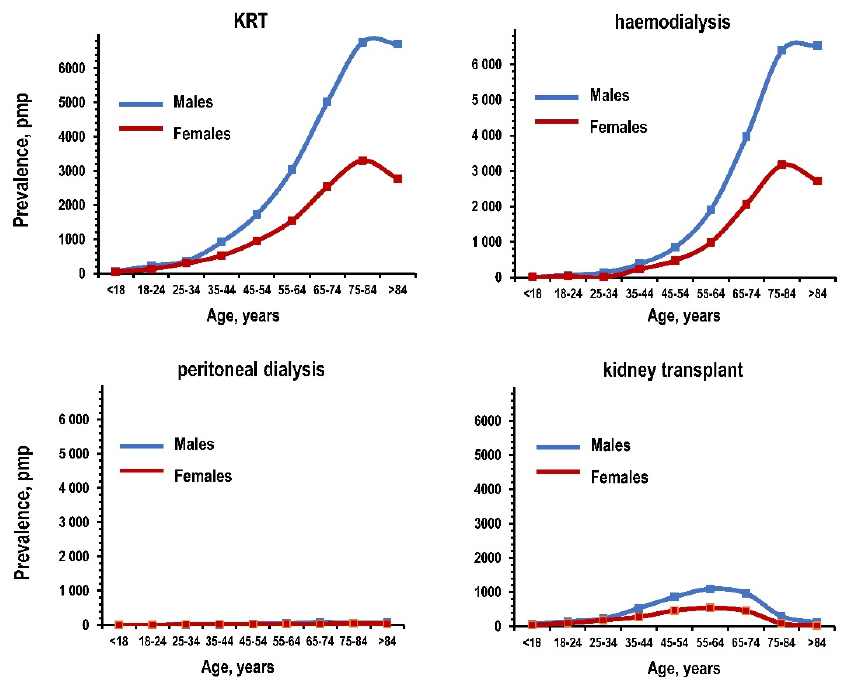
Figure 1. Prevalence of kidney replacement treatment, haemodialysis, peritoneal dialysis, and kidney transplant among residents of the Campania region in the year 2017: patients per million population (pmp) by age and gender. Notes: blue line for males and red line for females. KRT: kidney replacement treatment.